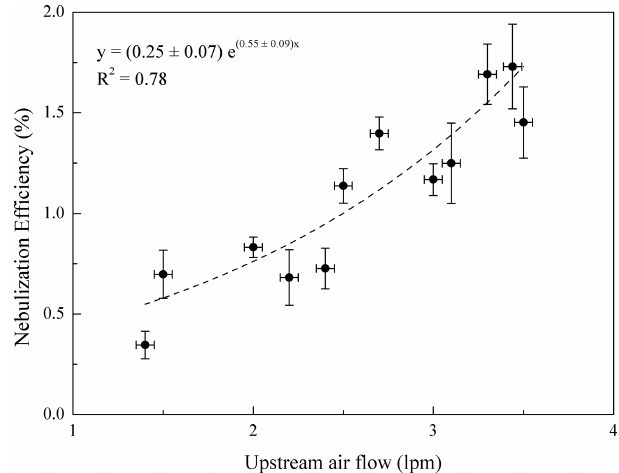
Figure 3. BLAM nebulization efficiency (percentage values) vs. up- stream air flow. Liquid feed rate = 0.4mLmin − 1